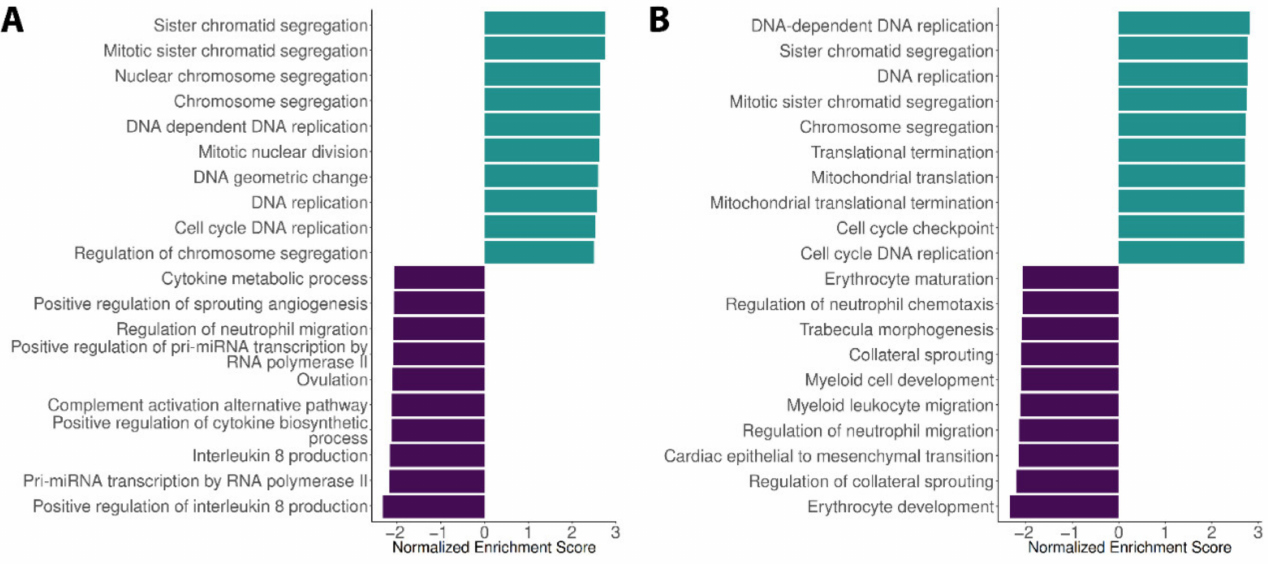
Figure 2. Top 20 Gene Ontology Biological Process (GO-BP) in the two blood datasets: ( A ) GSE18090 and ( B ) GSE51808 pathways (cut-off values: nominal p -value < 0.05 and FDR < 0.25). Positive NES (in purple) represents upregulated pathways in the infected individuals versus controls, while negative NES values (in green) represent downregulated pathways in the infected individuals versus